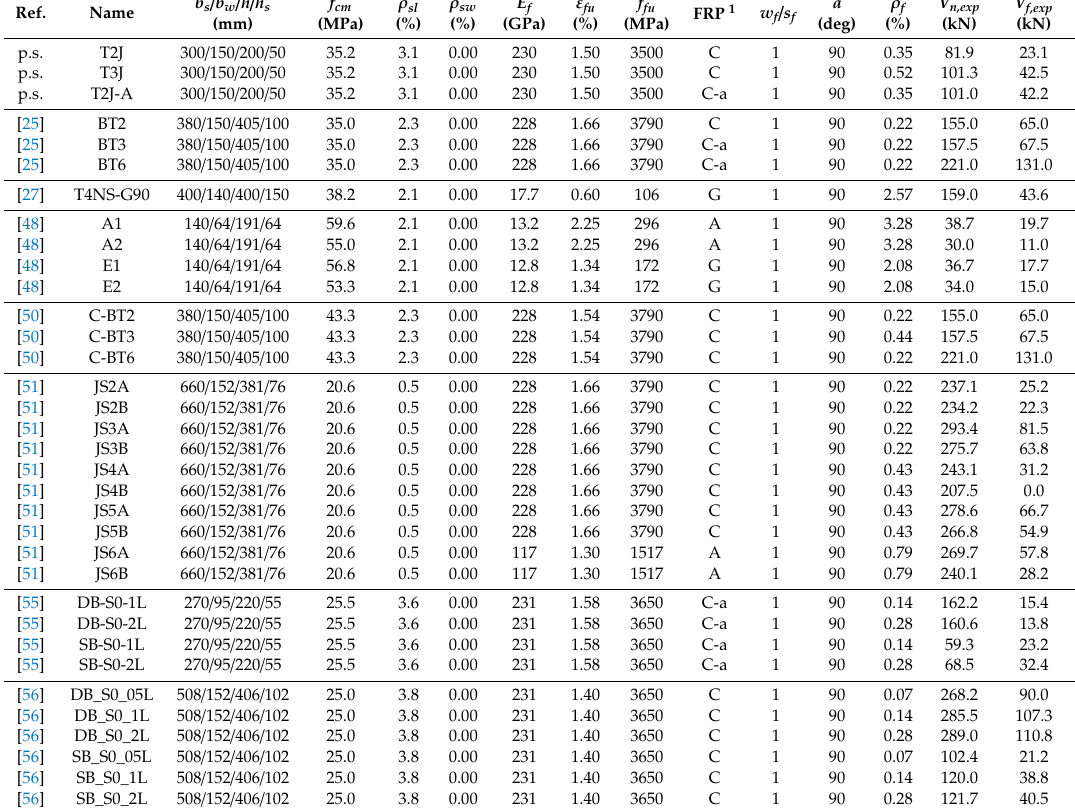
Table A2. Properties of the retrofitted T-beams with EB-FRP continuous U-jackets without stirrups of the database.